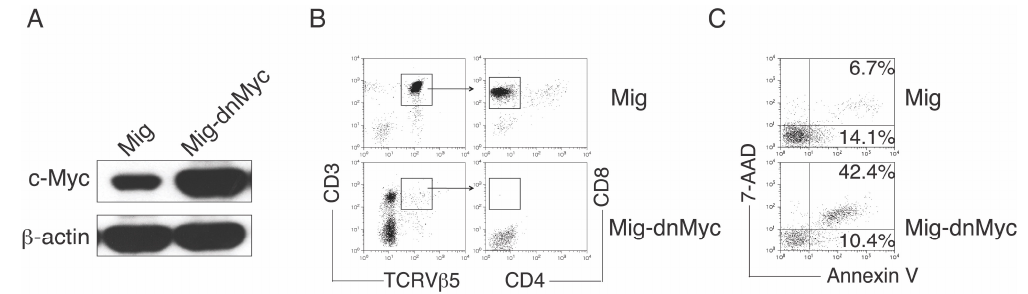
Figure 3 . c-Myc directs the Notch signaling – mediated differentiation of HSC-T cells. Bone marrow – derived CD117 + HSCs from OT-I TCR transgenic mice were co-cultured on SNL feeders and transduced with retroviral vectors (Mig or Mig – dn c-Myc). Green fluorescent protein (GFP + ) HSCs cells were isolated and co-cultured with OP9-DLL1/DLL4 cells and cytokines (IL-7 and Flt3L). ( A ) DN c-Myc transduction. GFP + HSCs were isolated and analyzed for c-Myc and β - actin by immunoblot; ( B ) Differentiation of HSC-T cells in vitro. Flow cytometric analysis for the protein expression of HSC- derived cells on day 20; ( C ) Apoptosis of GFP + HSCs on day 4 based on staining of Annexin V and 7- AAD and analyzed by flow cytometry. Data are representative of three independent experiments.